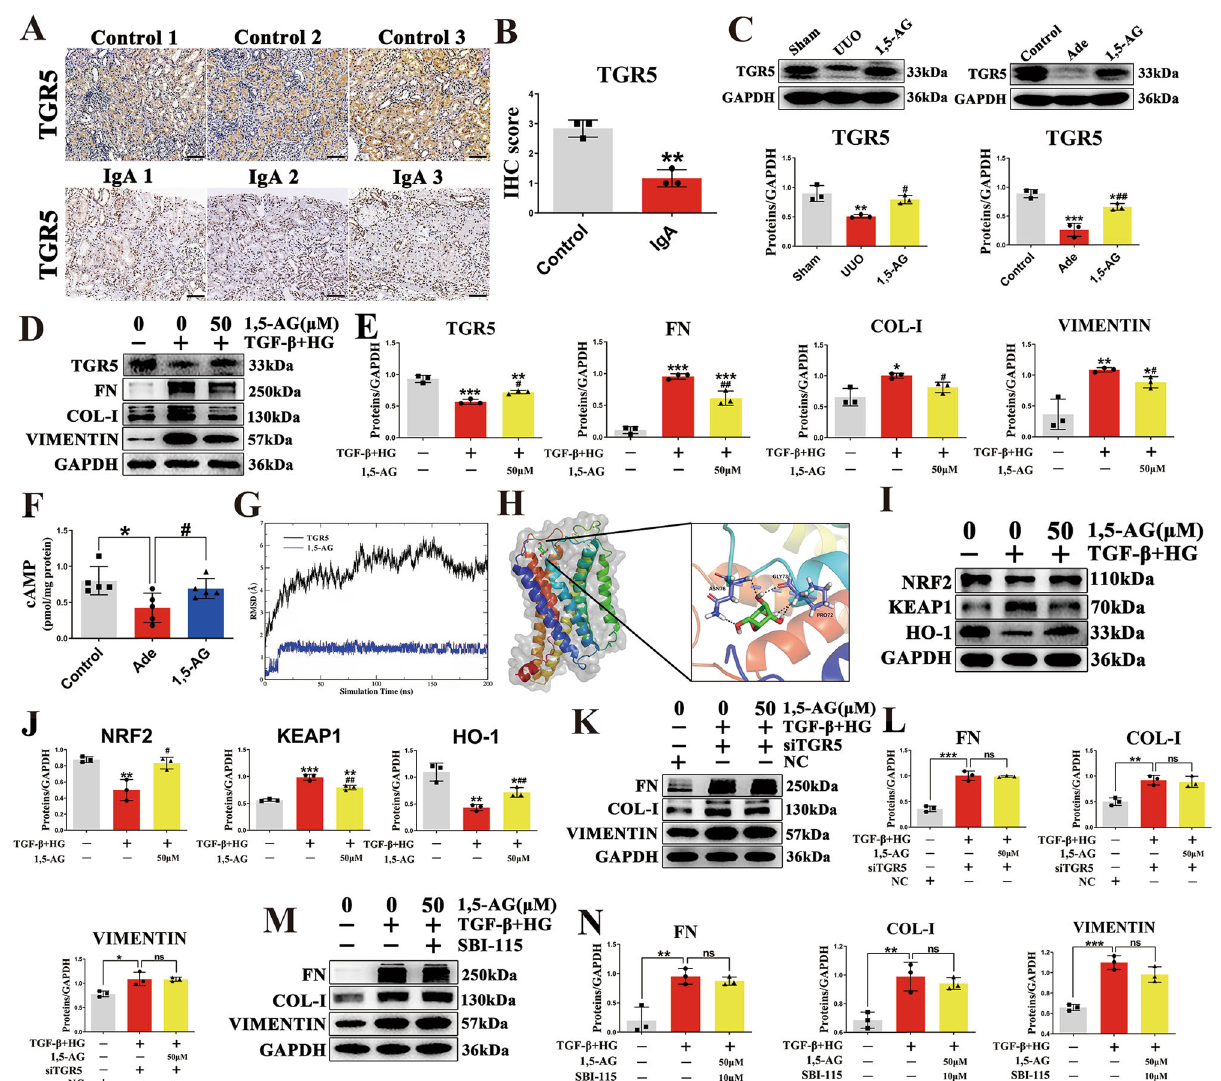
Fig. 4 | 1,5-AG as an agonist of TGR5 and knockdown of TGR5 abolishing the anti- fi broticeffectof1,5-AG.A ImmunohistochemicalmicrographsofTGR5inthe kidney tissues of IgA patients (scale bar, 100 μ m). B IHC scores of Fig. 4A ( n =3) ** p =0.0021. C TGR5 protein expressions of kidney in UUO and adenine models. ** p =0.0054forUUOmodel:Shamvs.UUO, p =0.5034forUUOmodel:Shamvs.1, 5-AG, # p =0.0237forUUOmodel:UUOvs.1,5-AG;*** p =0.0003foradeninemodel: Controlvs.Ade,* p =0.0446foradeninemodel:Controlvs.1,5-AG, ## p =0.0034for adenine model: Ade vs. 1, 5-AG. D TGR5, FN, Col-I and Vimentin expressions in primary mouse renal tubular cells (PRTC) after treatment with TGF- β (10ng/mL) + high glucose (30mM) and 1,5-AG(50 μ M). E Quantitative analysisof Fig. 4D ( n =3). *** p = 0.0001 for TGR5: Control vs. Model, ** p = 0.0028 for TGR5: Control vs. 1, 5- AG, # p =0.0137forTGR5:Modelvs.1,5-AG;*** p <0.0001forFN:Controlvs.Model, *** p =0.0006 for FN: Control vs. 1, 5-AG, ## p =0.0043 for FN: Model vs. 1, 5-AG; * p =0.0149 for COL-1: Control vs. Model, p =0.1713 for COL-1: Control vs. 1, 5-AG, # p =0.0247forCOL-1:Modelvs.1,5-AG,ComparisoninCOL-1wereperformedwith a two-tailed Student ’ s t test; ** p =0.0075 for VIMENTIN: Control vs. Model, * p = 0.0270 for VIMENTIN: Control vs. 1, 5-AG, # p =0.0231 for VIMENTIN: Model vs. 1, 5- AG, Comparison in VIMENTIN were performed with a two-tailed Student ’ s t test. F The cAMP levels in adenine model. * p =0.0130 for cAMP: Control vs. Ade, # p =0.0376forcAMP:Adevs.1,5-AG. G Therootmeansquaredeviation(RMSD)of